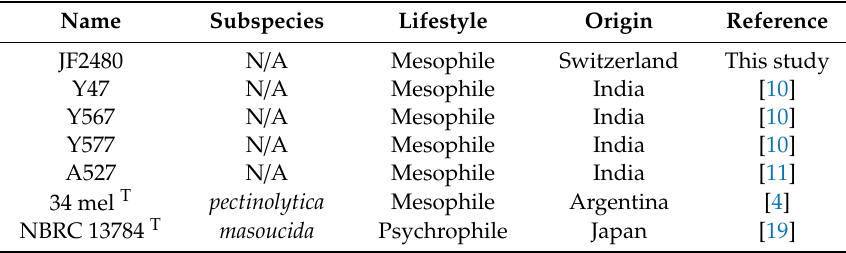
Table 1. A. salmonicida strains used in this